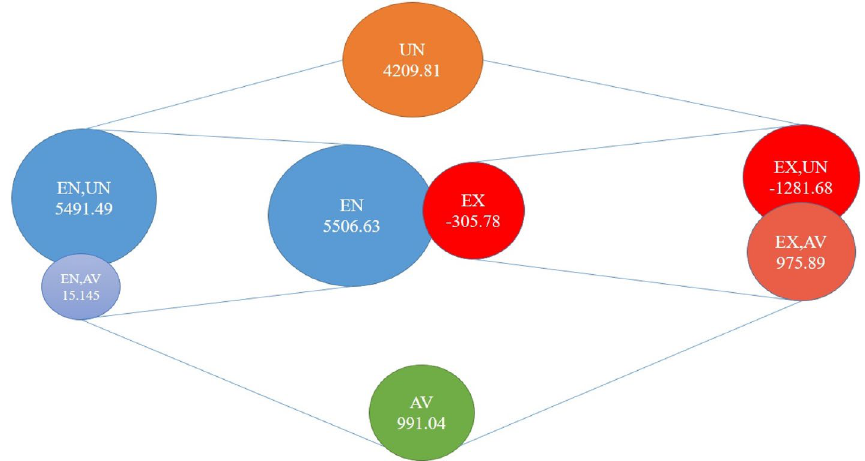
Fig. 6 Separation results of exergy destruction rates for the whole